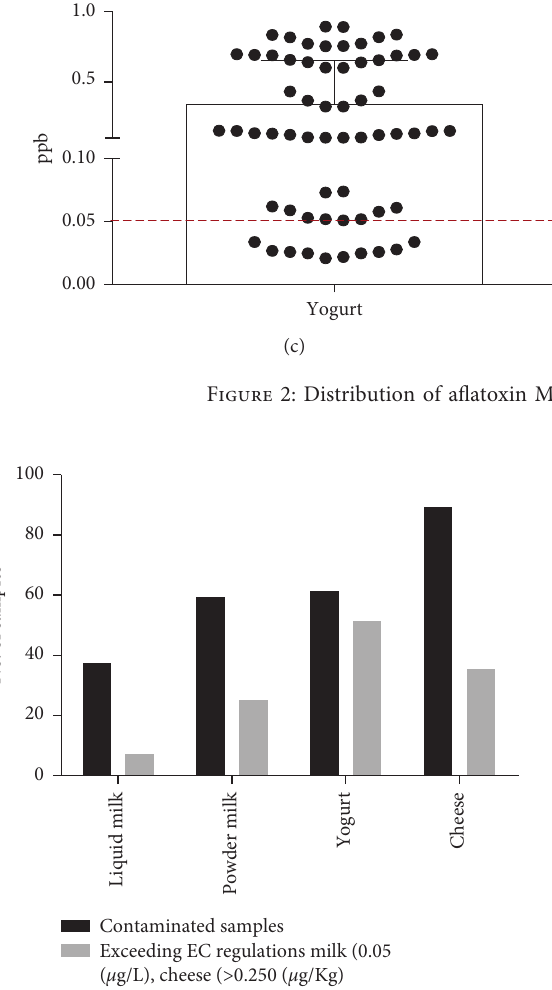
Figure 3: Aflatoxin M1 in different types of milk and milk